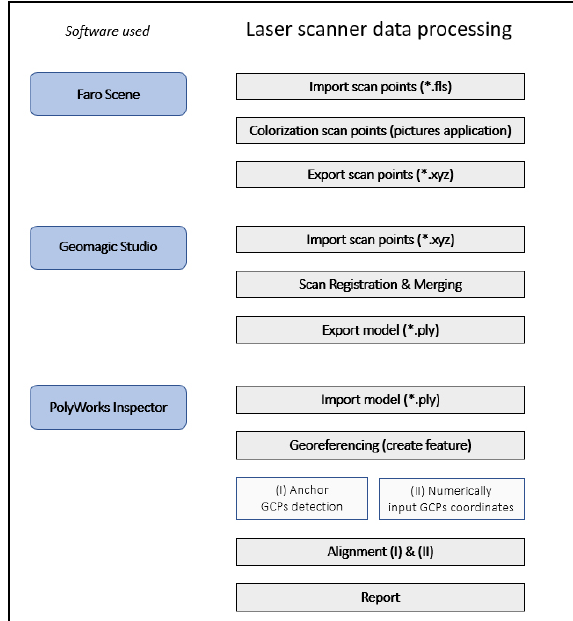
Figure 7 . Overall workflow of the laser scanner data processing.